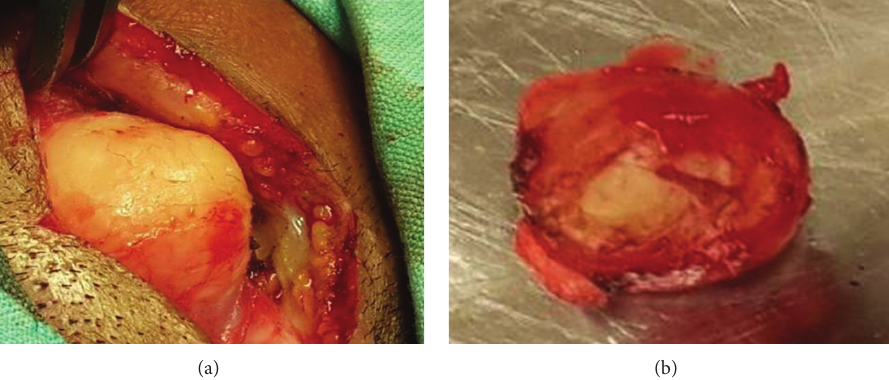
Figure 3: (a) Osteoma after freeing it all around before its excision. (b) The specimen after